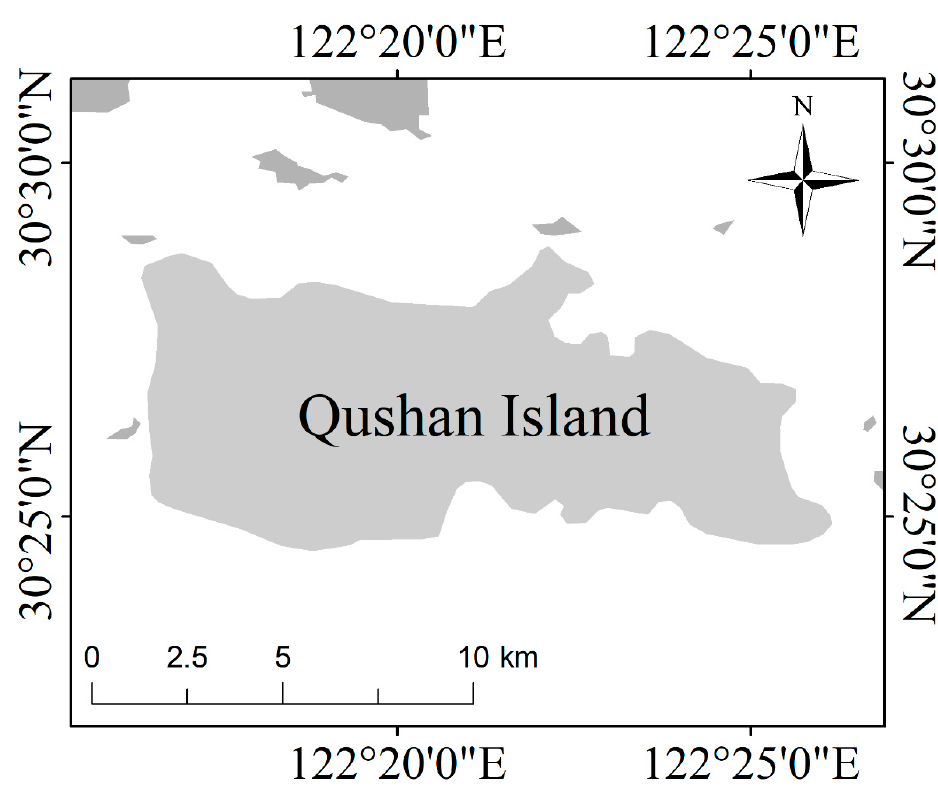
Remote Sens. 2022 , 14 , x FOR PEER REVIEW Figure 10. Location of Qushan Island, China. Figure 10. Location of Qushan Island, China.